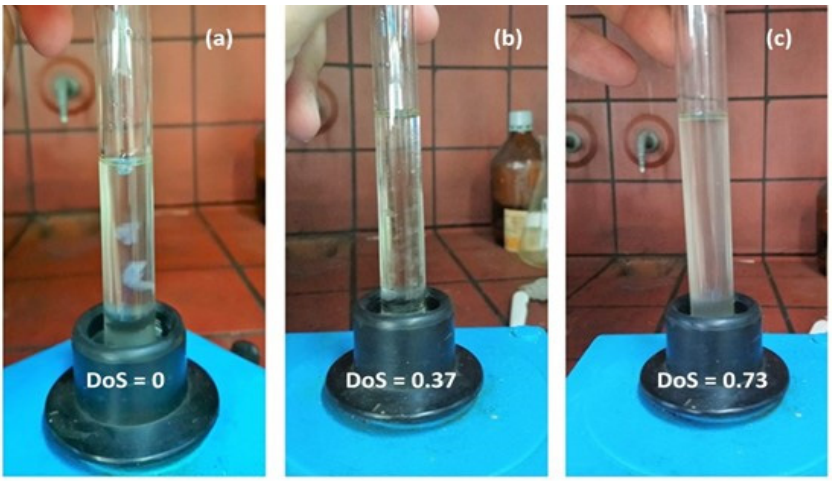
Figure 8. Solubility trials in DMSO. ( a ) α -(1,3) glucan; ( b ) noncatalyzed; ( c ) catalyzed.